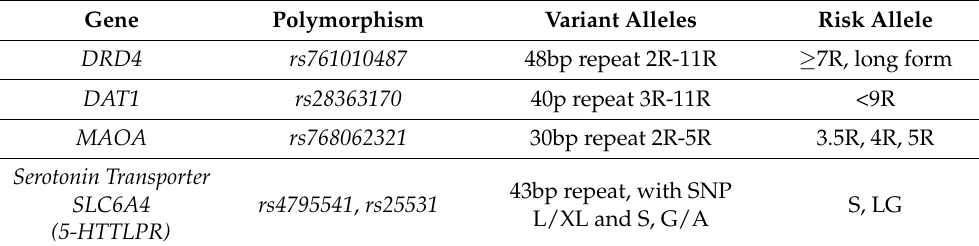
Table 3. Simple Sequence Repeats (Variable Number Tandem Repeats and Insertion/Deletions) *. Gene Polymorphism Variant Alleles Risk Allele